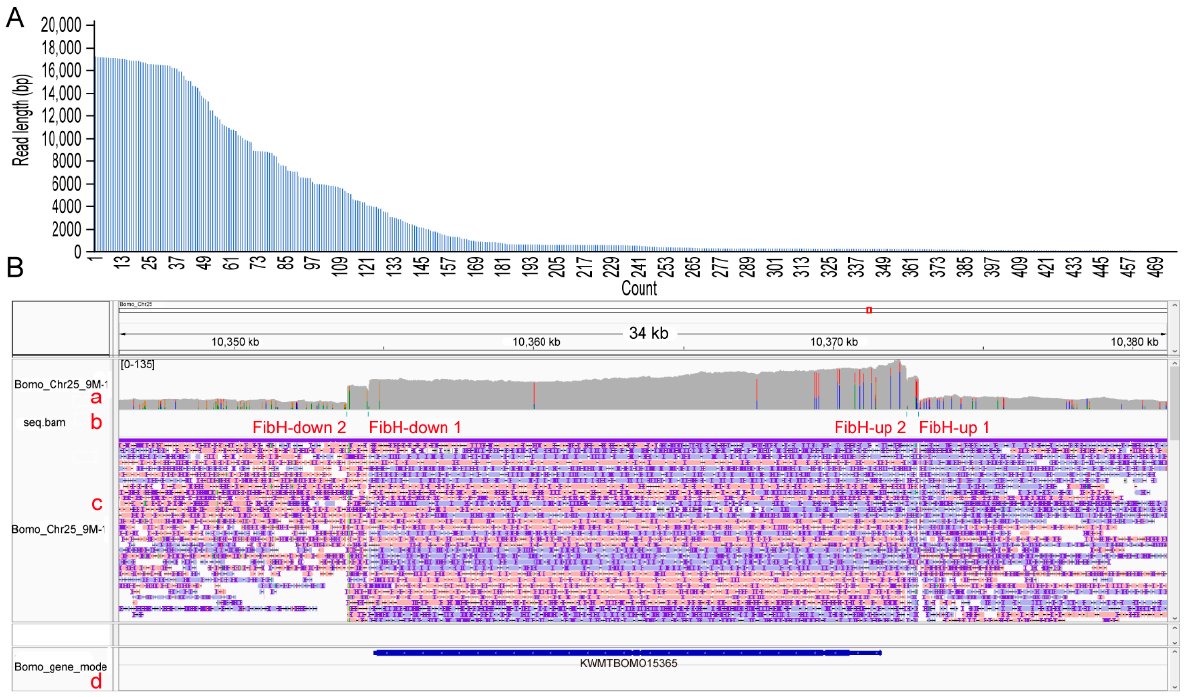
Figure 3. The coverage depth of the target region by Cpf1-based enrichment and ONT sequencing (CEO). ( A ) The length distribution of reads compared to the target region. The horizontal axis is read numbers numbered from high to low according to the read length; the vertical axis is the length of the reads compared to the target region. ( B ) Line a is the depth of read coverage; line b is the position of the crRNA sequence alignment and is marked with the name of the crRNA sequence, and the green line is its position; line c is the read alignment; line d is the gene annotation.